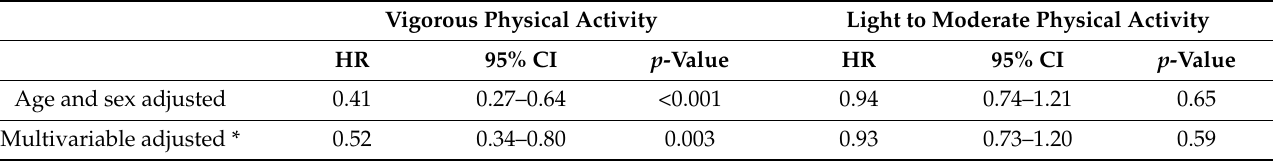
Table 2. HR for incident T2D associated with the substitution of one hour of sitting for one hour of vigorous or light to moderate physical activity.